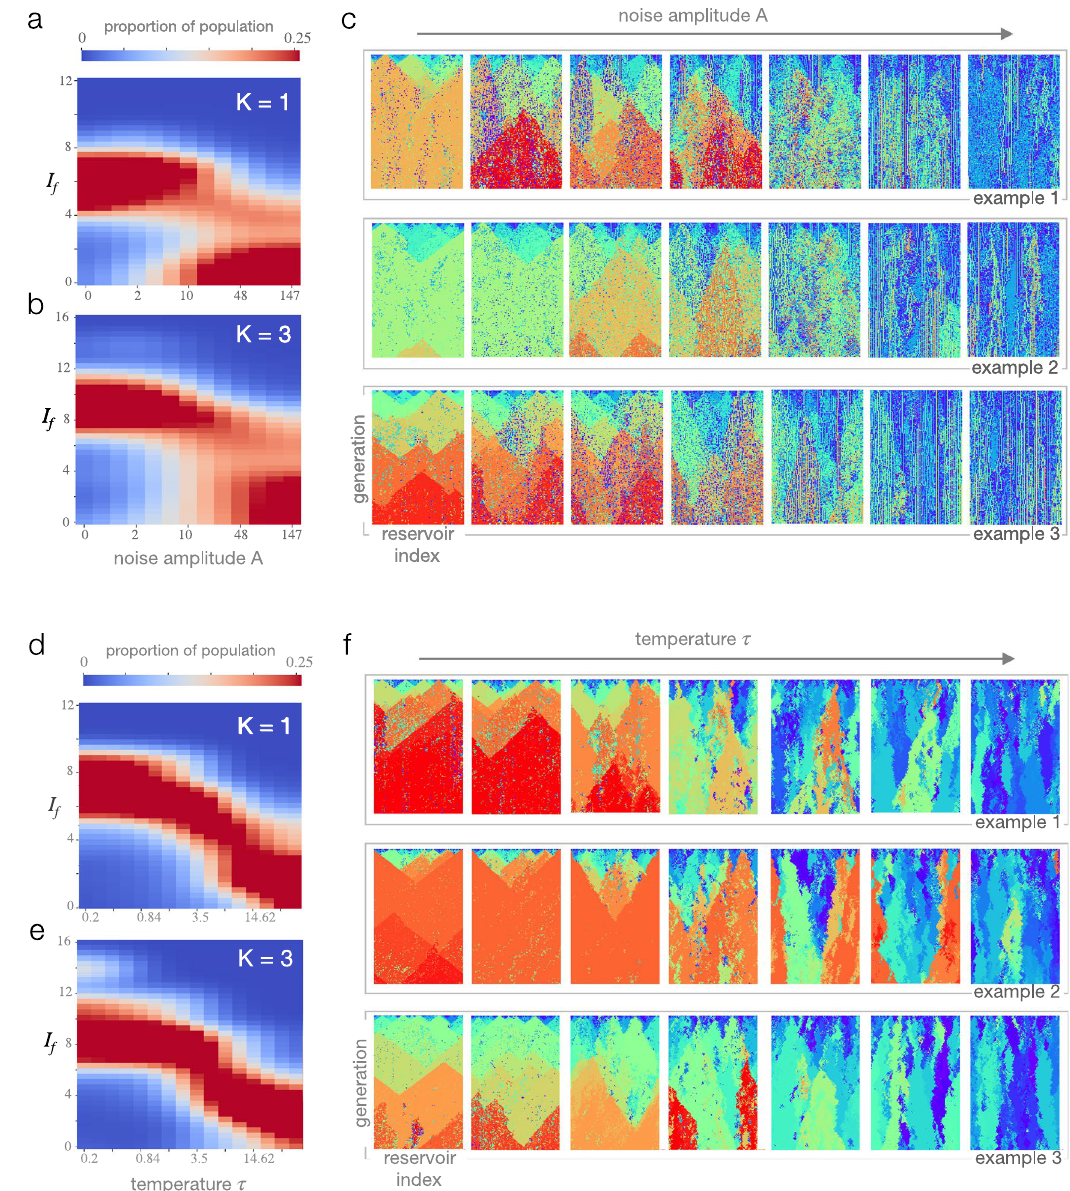
Figure 4. The effect of noisy copying ( a – c ) and stochastic selection ( d – f ). ( a , b , e , f ) Information gain distribution I f of the 200th generation, as a function of neural noise amplitude A ( a , b ) and of selection temperature τ ( d , e ), over a NK landscape with size N = 20 and ruggedness K = 1 ( a , c ) and K = 3 ( b , d ). Each column shows an average over 5 runs (see “Materials and methods” for details). ( c , f ) Neural phylogenies of specific runs over an NK landscape with N = 20 and K = 3 as a function of increasing neural noise amplitude A ( c ) and selection temperature τ ( f